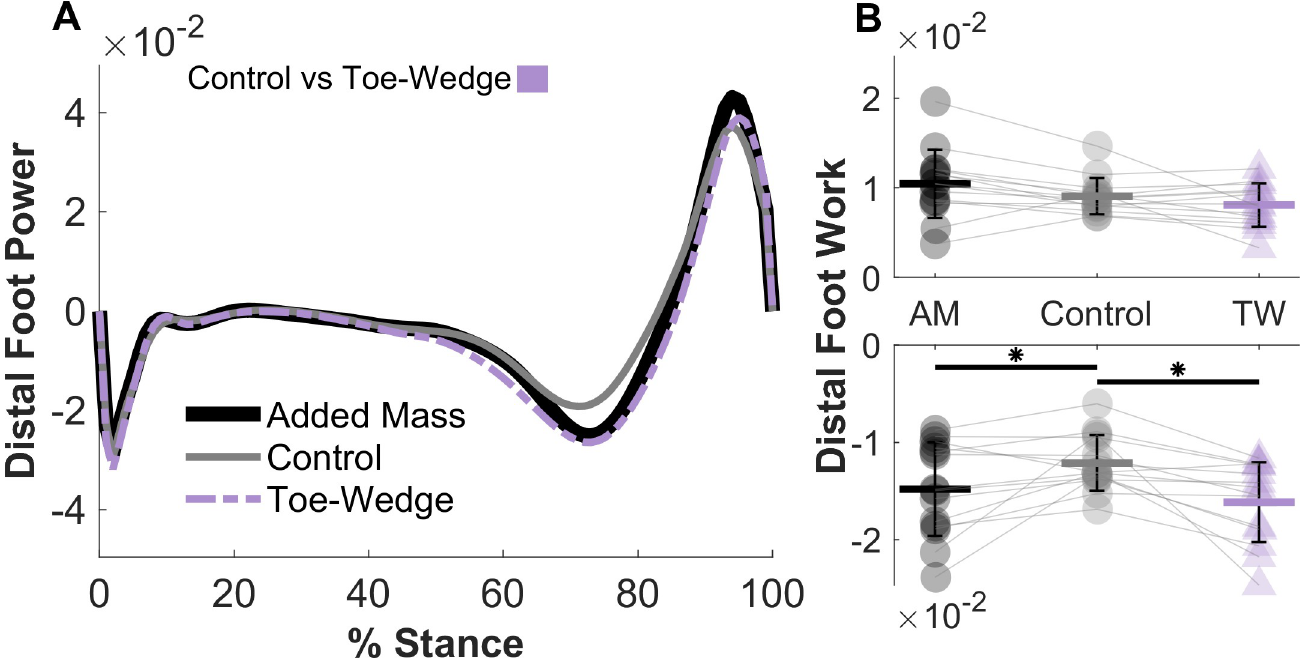
Fig 5. Distal foot mechanical work and power. (A) Mean mechanical power profiles and work (panel B) of structures distal to the rearfoot center of mass in the added mass, control, and toe-wedge conditions. In panel A, the horizontal bar indicates the timing of a statistically significant time-series differences between the control and toe-wedge conditions using a two-tailed paired t-test ( α = 0.017 after Bonferroni correction). (B) Distal foot negative work was greater in magnitude in the toe-wedge (TW) and added mass (AM) conditions than the control condition ( � in panel B indicates statistical significance at α = 0.017 after Bonferroni correction). Values for each participant are displayed in each condition, with grey lines connecting a single participant across conditions. Error bars represent the standard deviation.